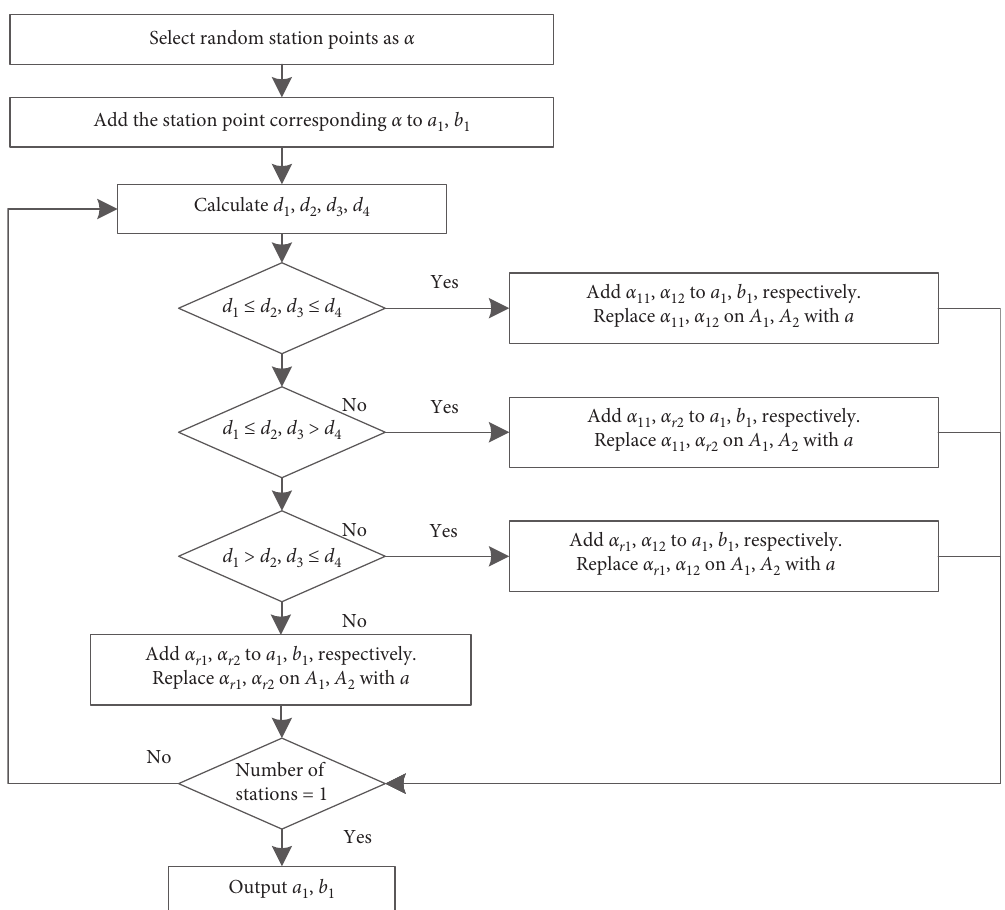
Figure 2: Flowchart of optimal nearest neighbor crossover operator.